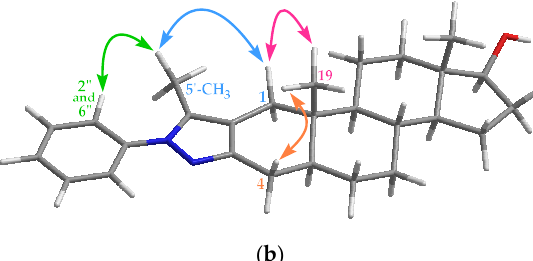
Figure 2. ( a ) Partial NOESY spectrum of compound 4a ; ( b ) NOESY correlations between protons observed for 4a.